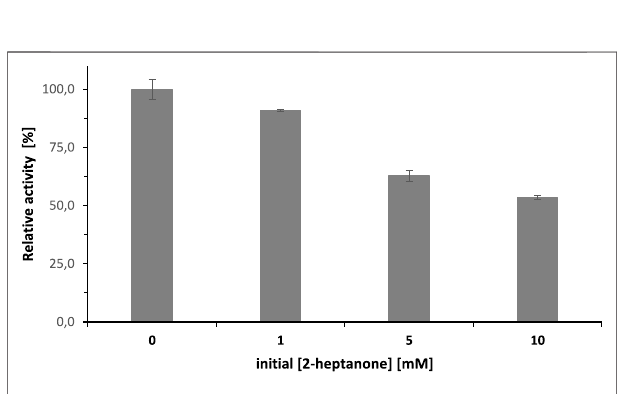
FIGURE 7 | The inhibitory effect of 2-heptanone concentration on the initial rate of Sy ADH-catalysed oxidation of rac -heptan-2-ol. Activity assay conditions:[ rac -heptan-2-ol]=10 mM,[2-heptanone]=0 – 10 mM,[NADP + ]= 0.5 mM, [SyADH-cell-free extract] = 2.1 U × mL − 1 (100% relative activity), [KPi,pH7]=50 mM,[DMSO]=5%v/v,incubationtime=1min,T=25 ° Ctotal volume: 1000 µL. Data are expressed as the mean ± SD of the three independent experiments.